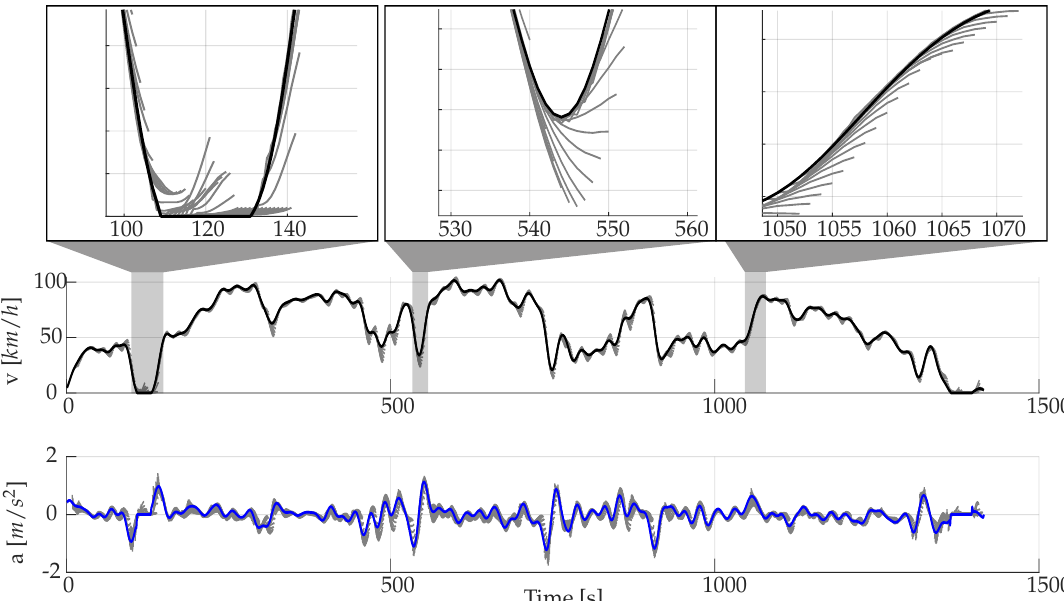
Figure 11. Predictions using FNN without slope [Driver 1/10 s prediction horizon].